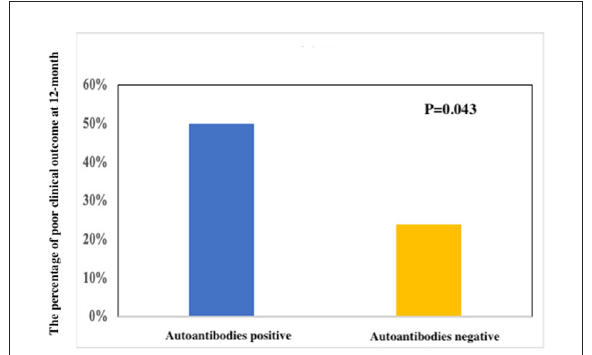
FIGURE1 Clinical outcomes between a poor clinical outcome and a good clinical outcome at 12 months in anti-NMDAR encephalitis.